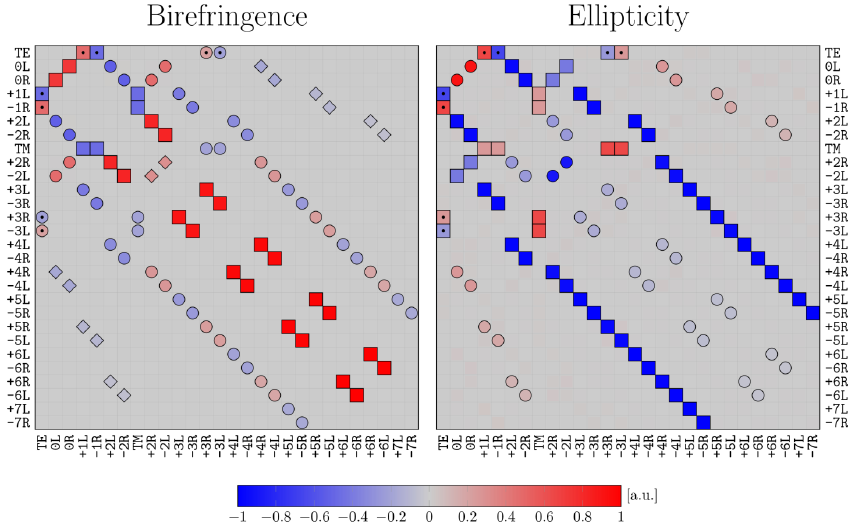
Figure 15. The calculated mode coupling coefficient under the influence of stress birefringence and core ellipticity. “ ” represents the coupling between dominant components, “ (cid:50) between dominant and weak components, and “ (cid:5) ” indicates the coupling between weak components. Reprinted with permission from Ref. [79] © The Optical